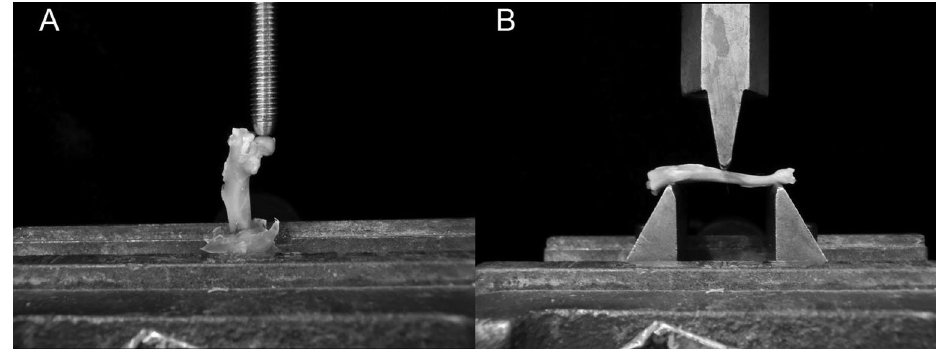
Figure 3. Mechanical testing. A , fl exo-compression test of the femora and B , 3-point bending fl exural test of the tibiae.